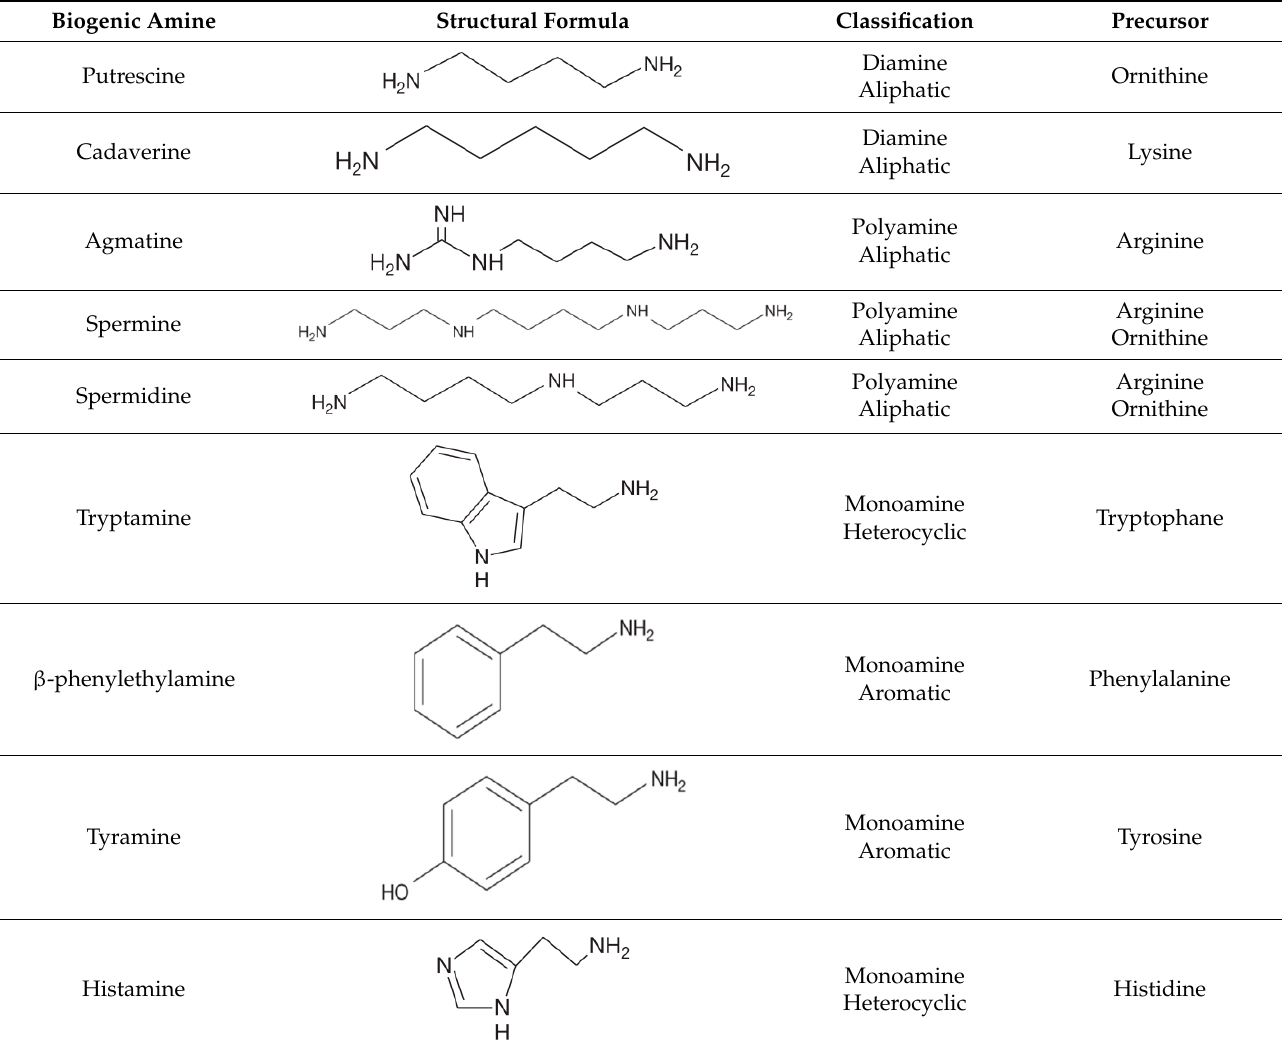
Table 1. Classification of biogenic amines [28].